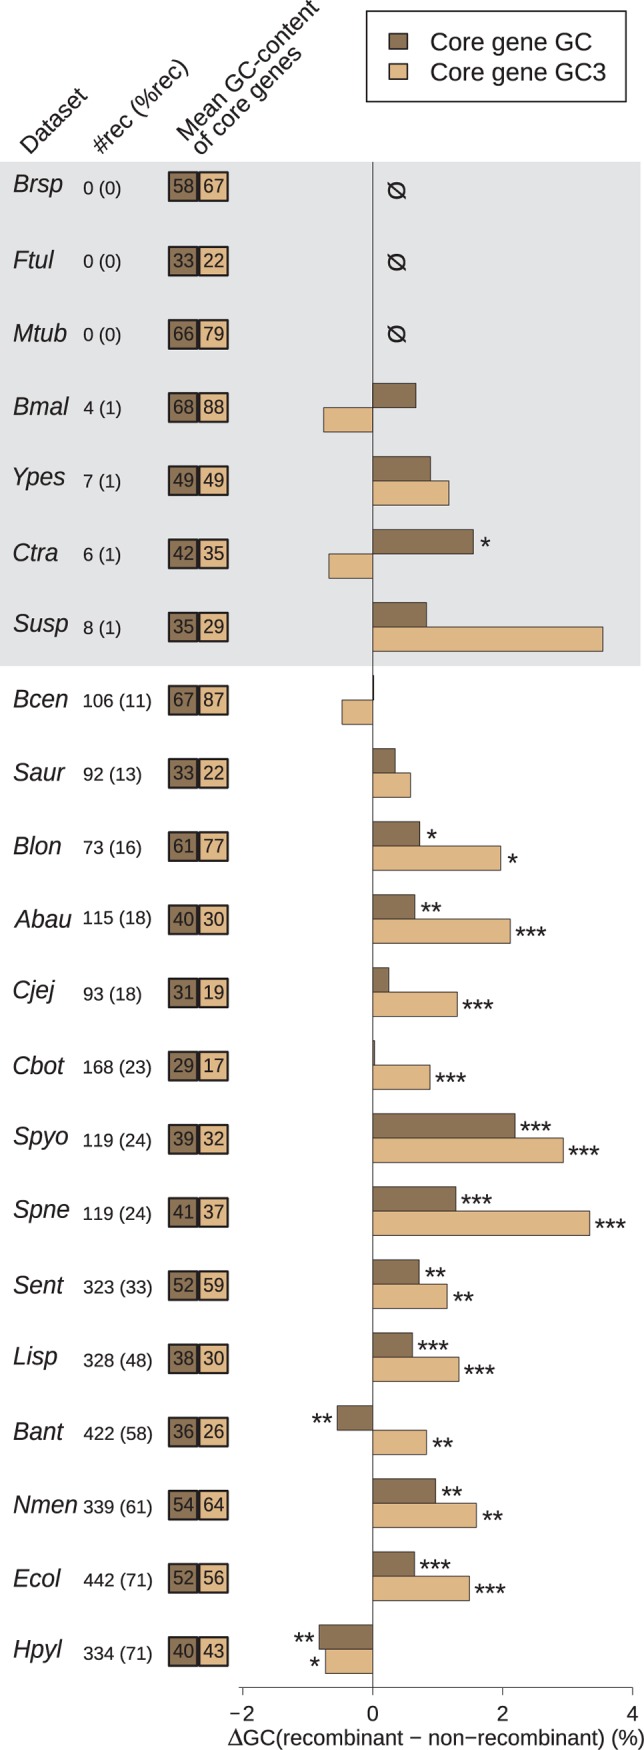
Effect of recombination on core genes GC-content.Difference in average GC-content of recombinant and non-recombinant genes, measured on entire CDS length (GC, dark brown) or at third codon position only (GC3, light brown) in the core genome of each dataset. Recombinant status was determined using the PHI test [28] (p < 0.05) on alignments of core gene families trimmed to a common length of 900bp. A positive difference indicates that recombinant families are enriched in GC. Stars indicate the level of significance of a Student’s t-test (“*”, p < 0.05; “**”, p < 0.01; “***”, p < 0.001). Statistical tests are detailed further in S1 Table. Dataset abbreviations are explained in Table 1. Figures next to dataset names indicate the number of recombinant core gene families in the dataset, figures in parenthesis indicate their percentage in the total pool of recombinant and non-recombinant families. Colored boxes on the right indicate the mean percentage of GC and GC3 values of core genes. Shading in background marks datasets with less than 20 recombinant gene families (detailed Table 1).